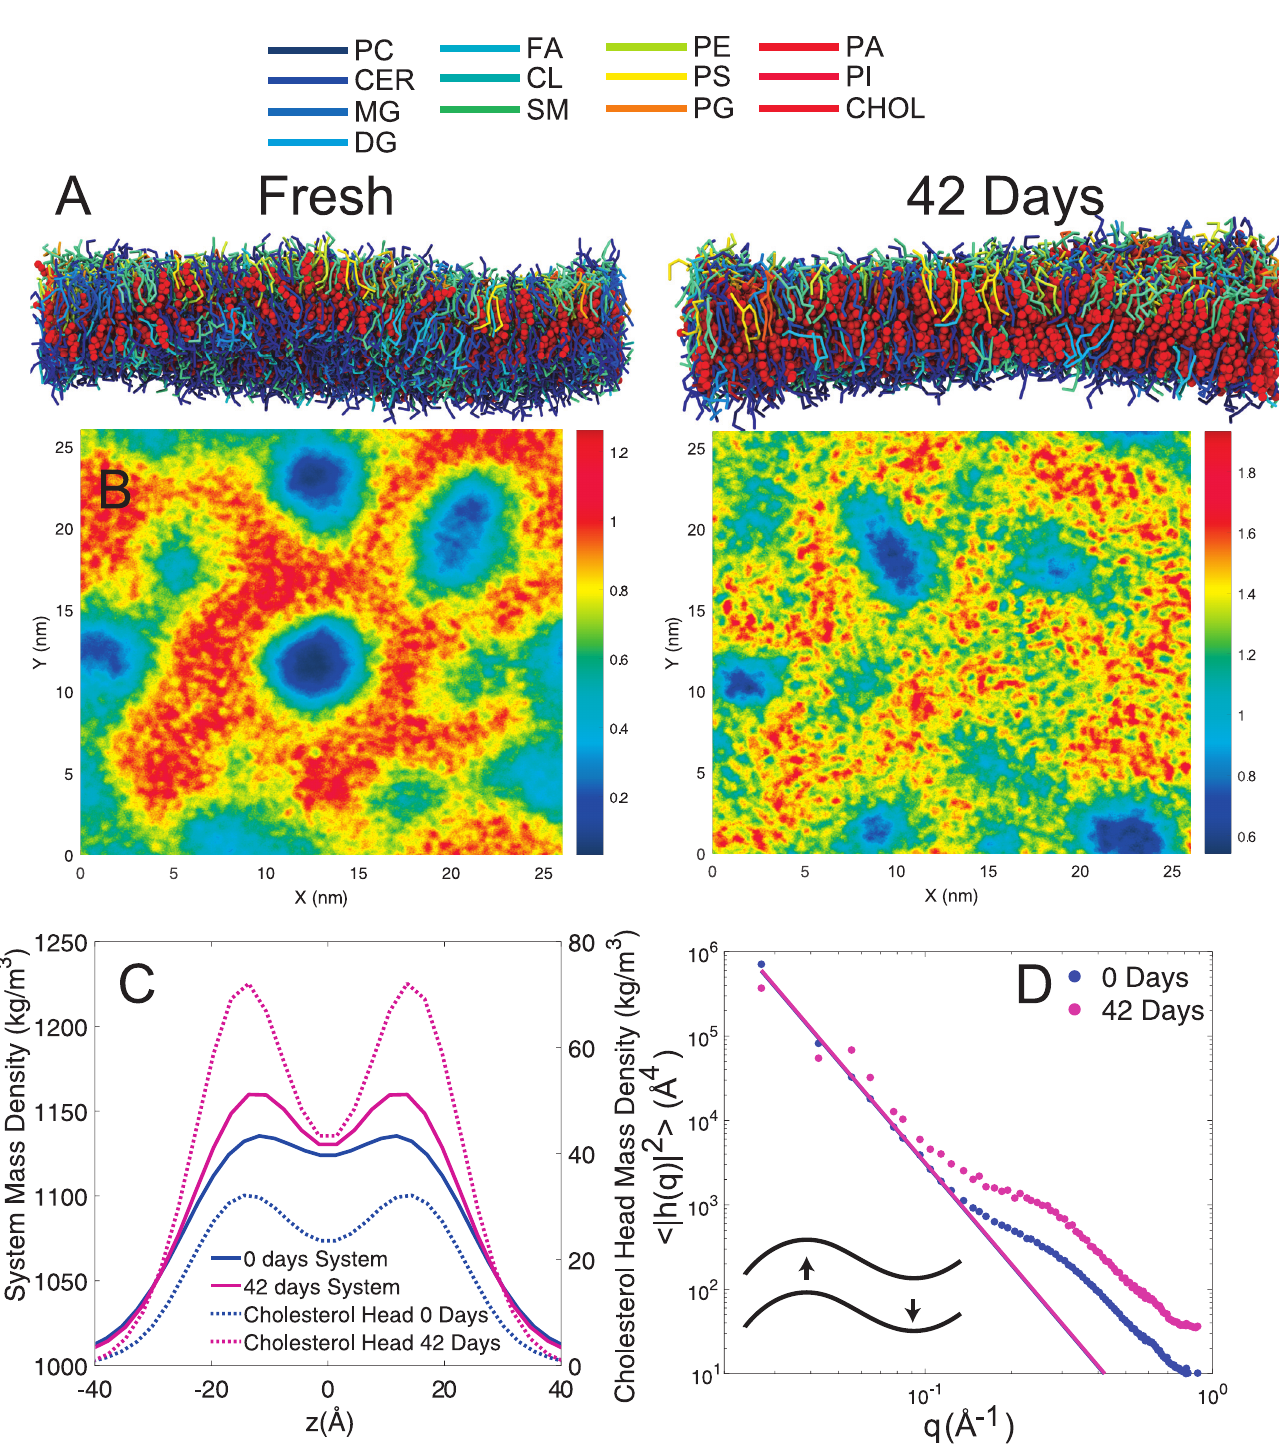
Fig 4. A 3-dimensional render of a simulated RBC patch after 2 μ s. Lipid molecules are displayed as rods symbolizing molecular bonds. Cholesterol is depicted as cm red spheres. Each lipid species (Phosphatidylcholine, PC; Ceramide, CER; Monoglucosyl lipids, MG; Diacylglycerol lipids, DG; Fatty acids, FA; Sphingomyelin, SM; Phosphatidylethanolamine, PE; Phosphatidylserine, PS; Phosphatidylglycerol, PG; Phosphatidic acid, PA; Phosphatidylinositol, PI) are represented by different colors indicated in the legend. B Cholesterol density maps averaged over the last 800 ns of the simulation. Red indicates cholesterol rich areas while blue represents cholesterol depletion. C Mass density profiles averaged over the last 800 ns of the simulation for the entire membrane patch (System) and the cholesterol head groups. D Fluctuation spectrum of the 42 day old membrane patch. The bending modulus κ was determined by fitting Helfrich–Canham (HC) theory.